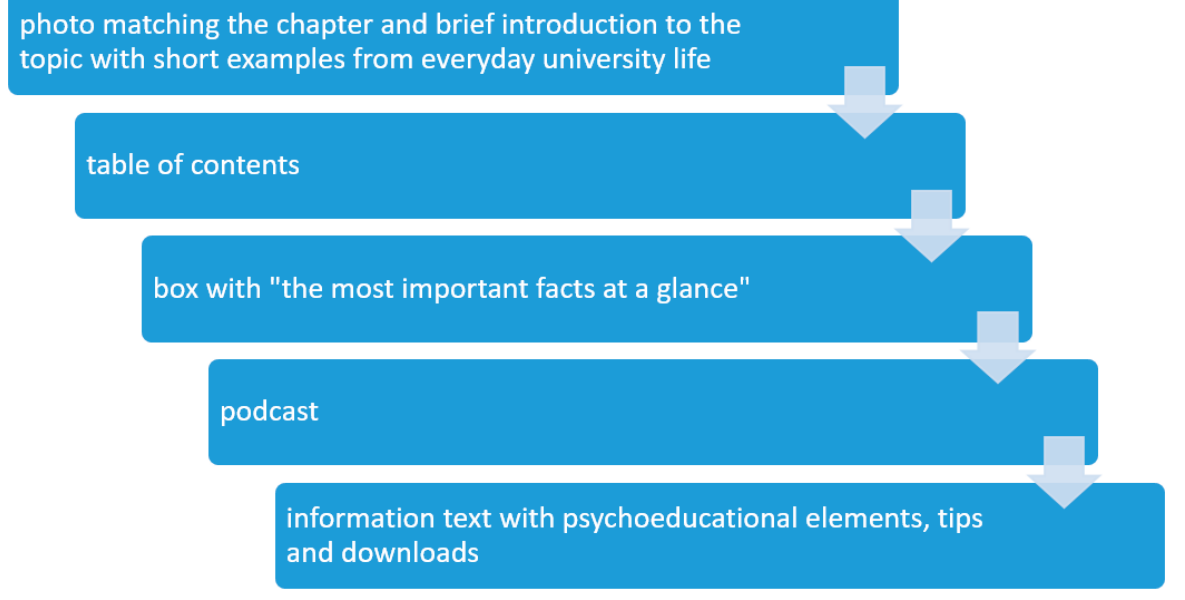
Figure 1. Structure of each chapter of the website (me@JGU).